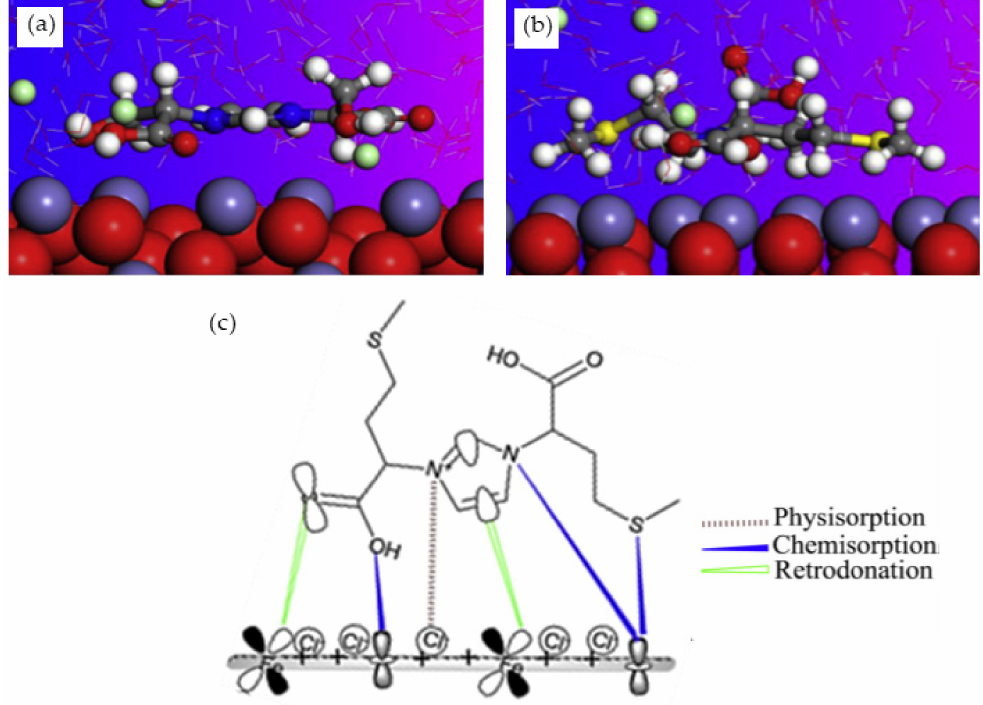
Figure 5. Side view of ( a ) H-zwitterion; and ( b ) S-zwitterion adsorbed on α -Fe 2 O 3 (110) surface; and ( c ) adsorption model of S-zwitterion, reproduced from [54], with permission from Elsevier, 2020. Saranya and coworkers described the adsorption of three synthesized pyran deriva- tives; ethyl 2-amino-4-(4-hydroxyphenyl)-6-( p -tolyl)-4 H -pyran-3-carboxylate (HP), ethyl 2-amino-4-(4-methoxyphenyl)-6-( p -tolyl)-4 H -pyran-3-carboxylate (MP) and ethyl 2-amino- 4-(4-hydroxy-3,5-dimethoxyphenyl)-6-( p -tolyl)-4 H -pyran-3-carboxylate (HDMP) on